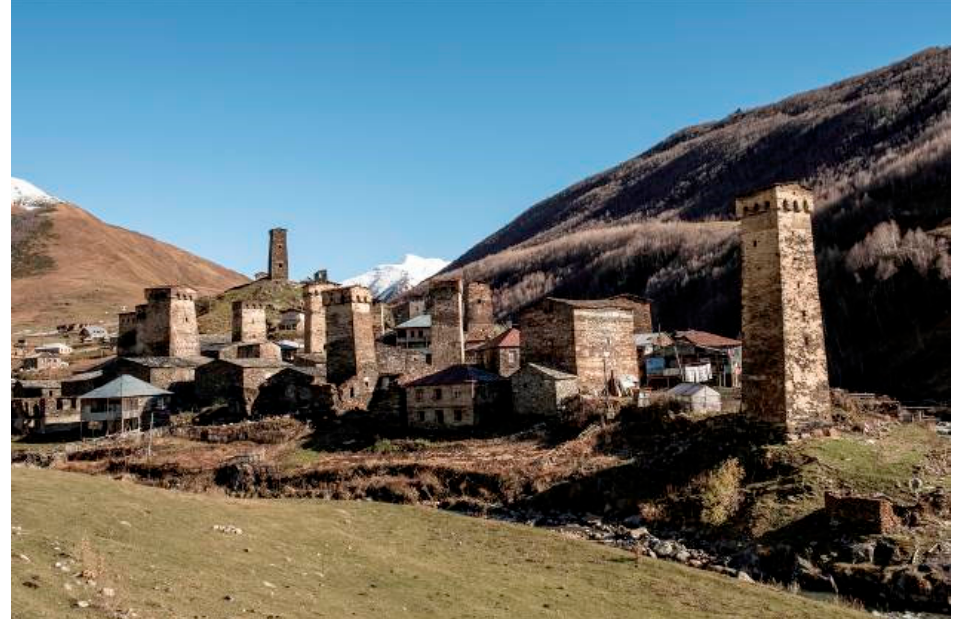
Figure 3. View of Chazhashi, the current World Heritage site in Ushguli, which in the Soviet era was known as the Ushguli–Chazhashi Museum Reserve and has held protected status since 1971 (Applis 2018).